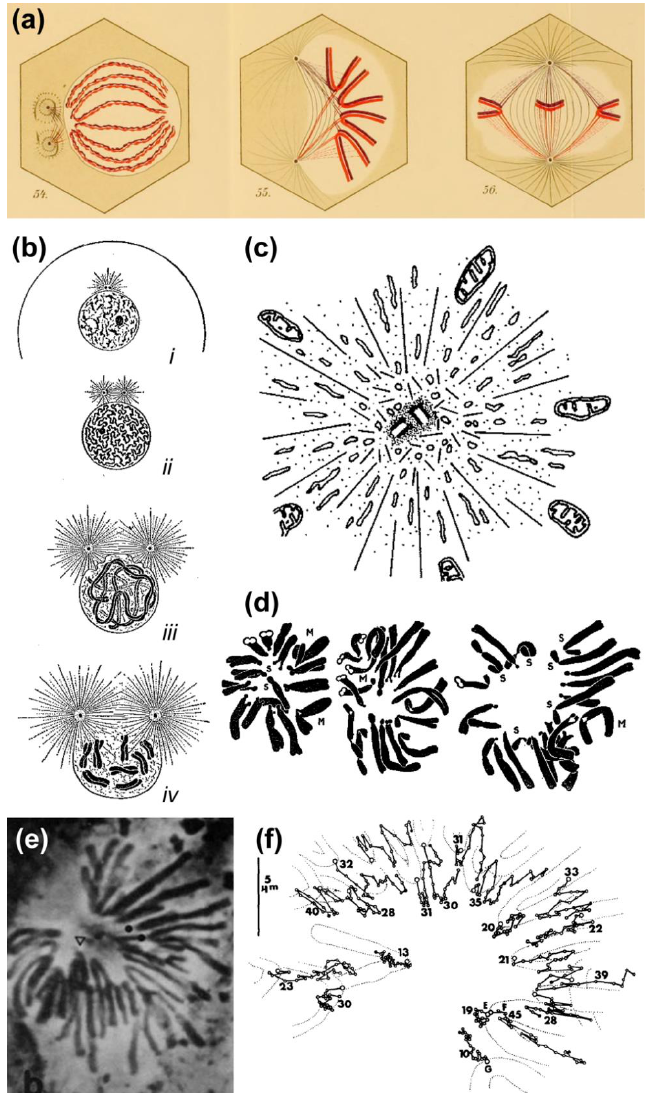
Figure 3. Evidence that centrosome-derived microtubules can exert pushing forces. ( a ) Original Drawings by Drüner depicting the invasion of the chromosomal region by microtubules, which exert a pushing force that assists chromosome alignment at the spindle equator. Reprinted from Drüner, 1895 [12]. Image courtesy of Biodiversity Heritage Library. http://www.biodiversitylibrary.org; ( b ) Schematic drawing by E. B. Wilson illustrating the pushing action of centrosomal microtubules on the nuclear envelope and subsequent rupture. Reprinted from Wilson, 1925 [10]. Image displayed under a Creative Commons Attribution-Noncommercial-Share Alike 4.0 International license, as described at https://creativecommons.org/licenses/by-nc-sa/4.0/legalcode. Image courtesy of the Wellcome Library. http://wellcomelibrary.org; ( c ) Schematic drawing by Luykx illustrating the repulsive action of centrosomal microtubules over large organelles (mitochondria). Reprinted from Luykx, 1970 [40]. Courtesy of Elsevier; ( d ) Original drawings by Darlington illustrating the variability in chromosome positioning in pollen grain cells. Reprinted from Darlington, 1937 [1]. Image courtesy of Biodiversity Heritage Library. http://www.biodiversitylibrary.org; ( e , f ) Phase contrast image of a newt lung cell undergoing transient monopolar configuration. Kinetochore position was tracked over time, clearly demonstrating the oscillatory behavior of mono-oriented chromosomes in this system. Note that chromosomes do not travel all the way towards the pole. Reprinted from Bajer et al., 1982 [41] and displayed under a Creative Commons Attribution-Noncommercial-Share Alike 4.0 International license, as described at https://creativecommons.org/licenses/by-nc-sa/4.0/legalcode.